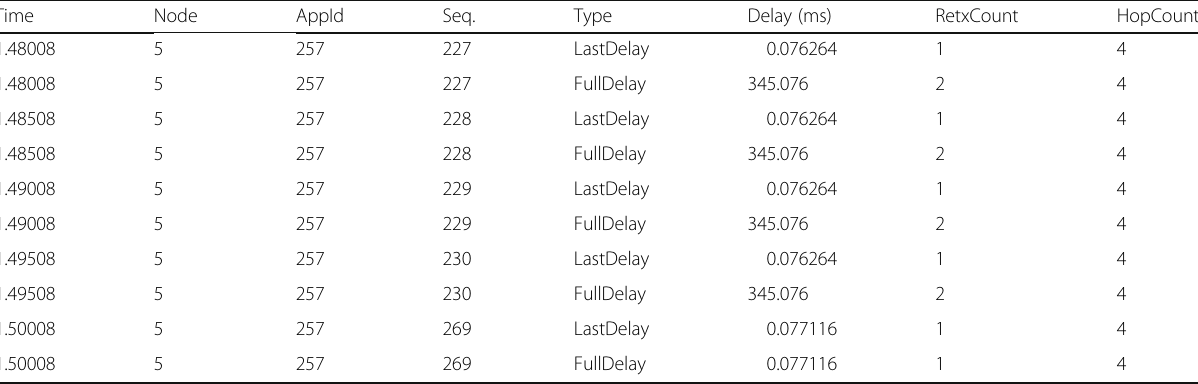
Table 1 Transmission delay in the V2V communications